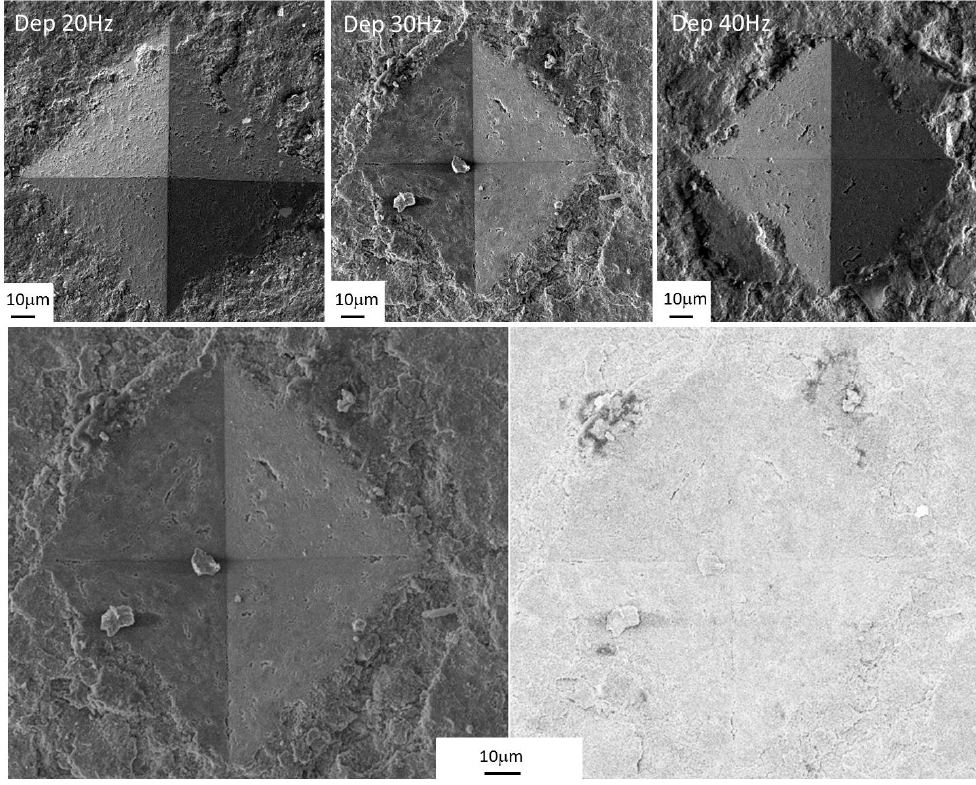
Figure 12. SEM images of the indenter imprint.